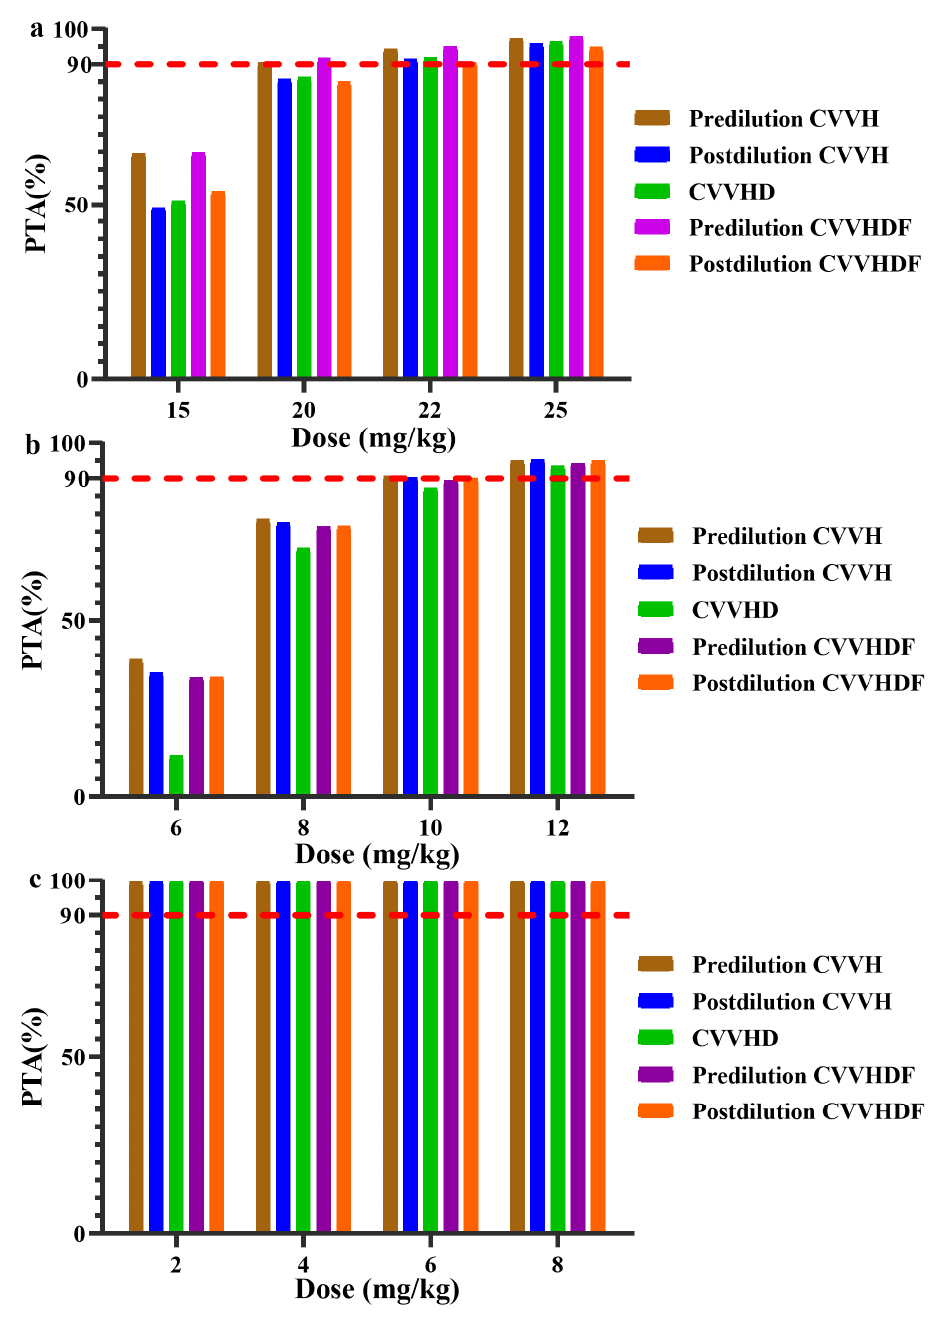
Figure 1. The probability of target attainment (PTA) values of antimicrobial agents in loading doses for patients undergoing different continuous renal replacement therapy modalities. The red dashed horizontal line indicates 90% PTA. ( a )—Vancomycin; ( b )—Teicoplanin; ( c )—Daptomycin.